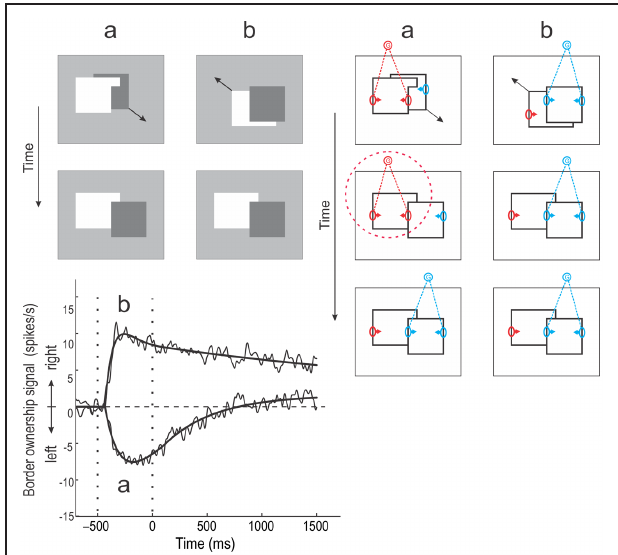
FIGURE 6 | Object continuity and persistence of grouping. (Top left) Two kinds of movement displays were used. In a , an inverted L shape initially occluded part of a dark square ( top ). The square then moved smoothly to a new position, resulting in the configuration shown below , which is typically perceived as a dark square occluding a white rectangle. Thus, the perceived direction of occlusion (border ownership) changes after the termination of movement. In sequence b , the dark square initially occludes the white shape and the latter then moves to a new position, resulting in the same final configuration as in a . (Bottom left) Average border ownership signals (difference between preferred and non-preferred side responses) for the two display sequences. In condition b , the border ownership signal shoots up shortly after the figures are presented (left vertical dotted line), reaching a peak and then decaying slowly. In condition a , the border ownership signal first turns negative, indicating ‘left’ border ownership, and then slowly drifts toward positive values. The vertical dotted line at time 0 indicates the end of the movement. At this time, the displays in the two conditions become identical, the only difference being the history of events. However, the border ownership signals remain different for at least 1500 ms. (Right) The Schematic illustration of the events in terms of the grouping cell model. In condition b , none of the borders changes assignment. During the movement, dynamic cues (accretion/deletion) as well as static cues (T-junctions, compact shape of square) define ‘right’ border ownership at the occluding contour. After the termination of movement, the static cues continue to activate the G-cell corresponding to the square ( blue ), keeping the occluding contour assigned. In condition a , dynamic cues and T-junctions initially indicate the left figure to be in front, activating the red G-cell most strongly. But when the movement terminates, the dynamic cues disappear and the static cues now indicate ‘right’ ownership for the occluding contour. However, the experiment showed that the border ownership neurons kept signaling ‘left’ for about 800 ms, indicating that the elevated activity in the G-cell persisted ( red dotted circle ). The persistence of border assignment despite the reversal figure–ground cues indicates that the grouping mechanisms have memory (see Discussion). (Modified from O’Herron and von der Heydt,